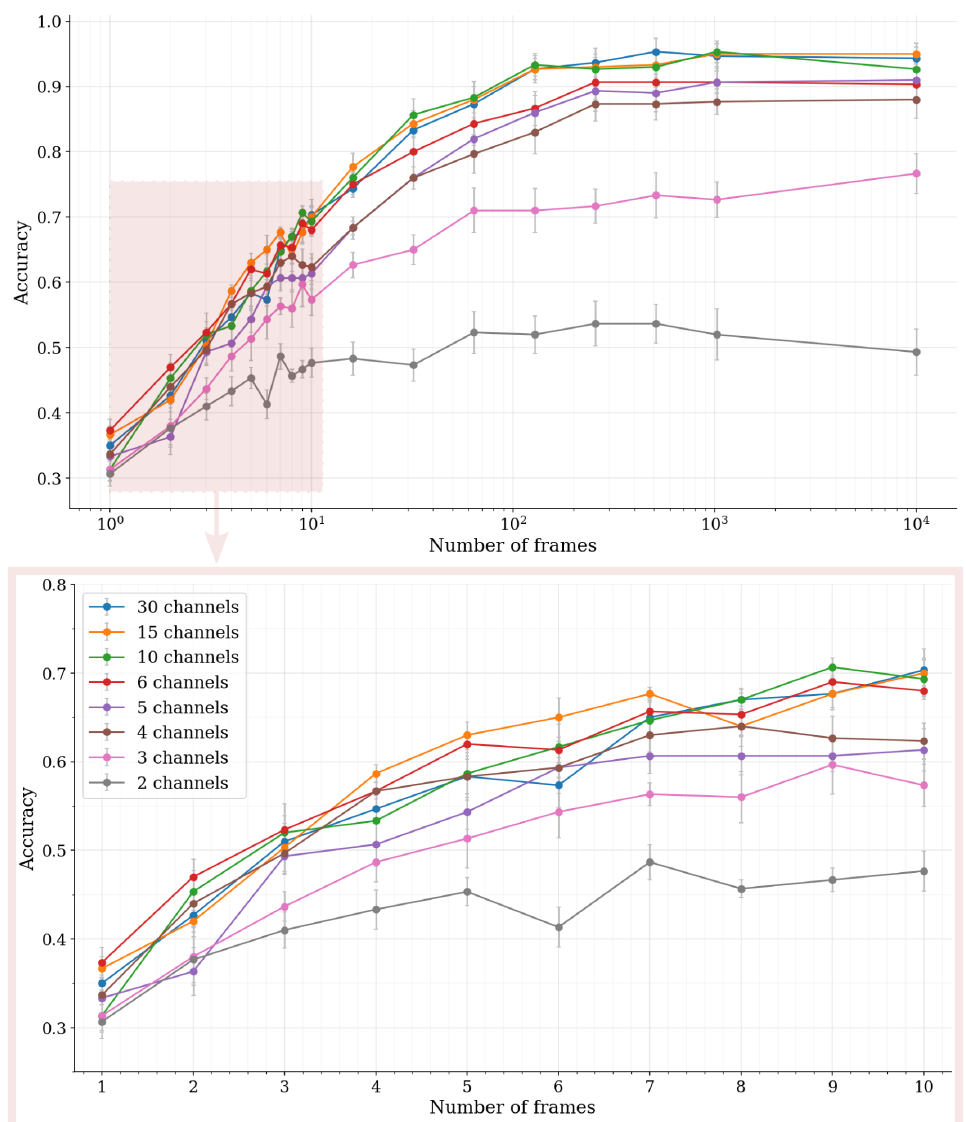
Figure 17. The mean classification accuracy (5-fold cross-validation) in the test set with respect to the block size (number of frames). The error bars denote the standard error of the mean